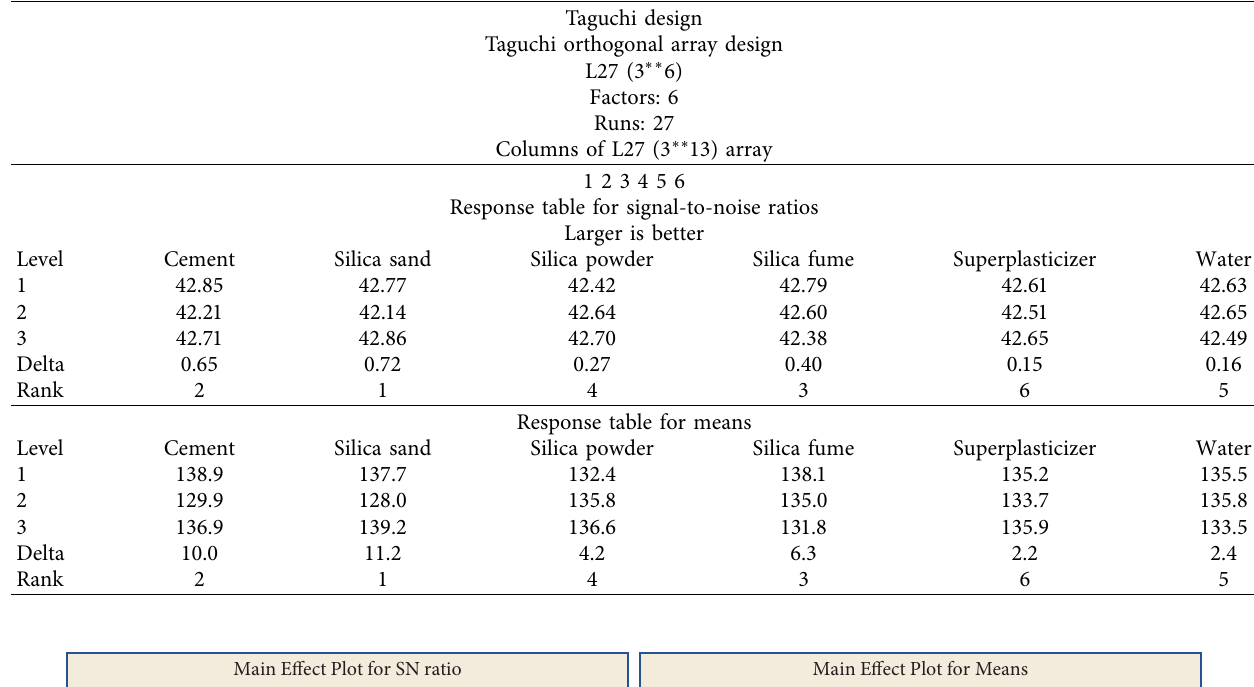
Table 13: Taguchi analysis for optimal compressive strength.